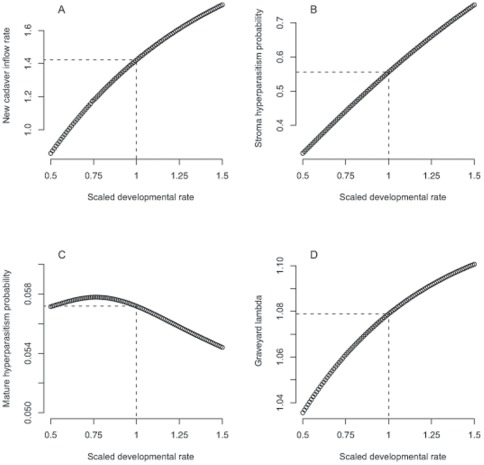
Sensitivity analysis of the estimated life-history parameters.The analysis was based on the stage structured graveyard growth model that fitted the empirical data best. Panel A: the new cadaver inflow rate b, panel B: the hyperparasitism rate in the stromal life state Ps, panel C: the hyperparasitism rate in the mature life stage Pm, Panel D: the graveyard growth rate λ. The variation in fungal developmental rate from 50% to 150% is plotted along the x-axes, relative to the average fungal development rate that was estimated from the field data (here represented by the relative value of 1). Dashed lines connect the expected mean for the y-axis estimate with this overall mean development rate.